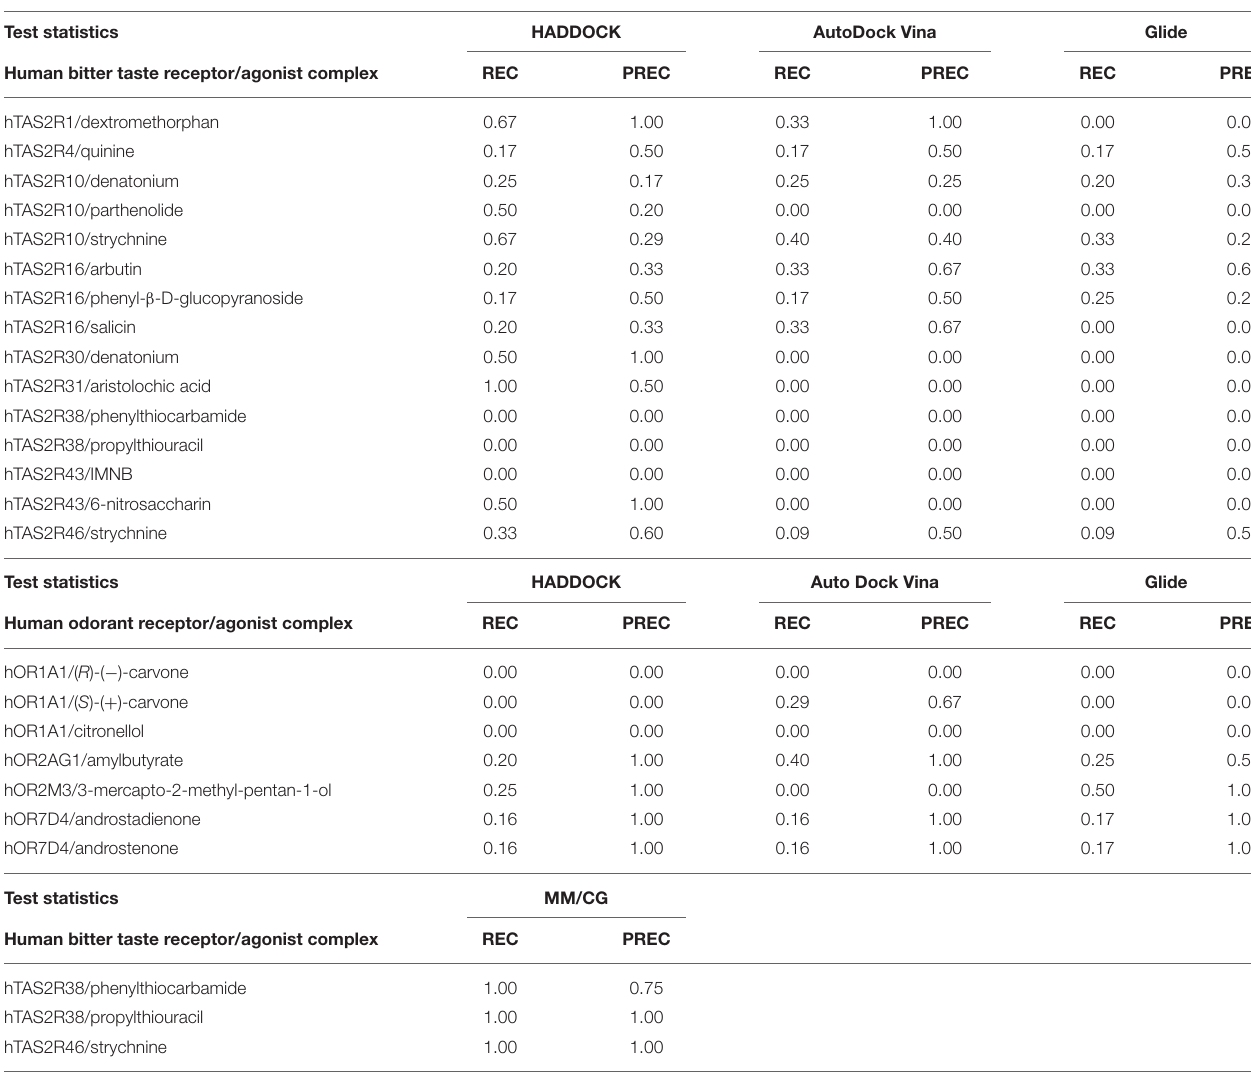
TABLE 3 | Performance assessment of the computational predictions of hChem-GPCR/agonist complexes, using the docking codes HADDOCK (Dominguez et al., 2003), AutoDock Vina (Trott and Olson, 2010), and Glide (Friesner et al., 2004) and MM/CG simulations (Marchiori et al., 2013; Sandal et al., 2015). Test